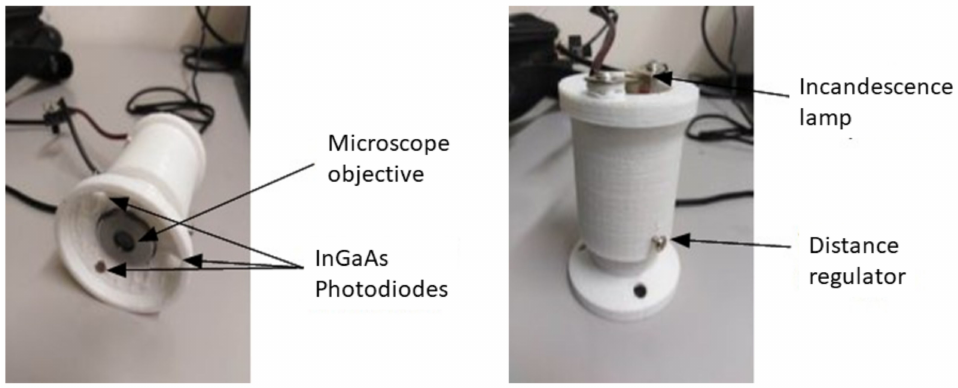
Figure 7. 3D printed microplastics sensor (IR-pass filter not shown in the